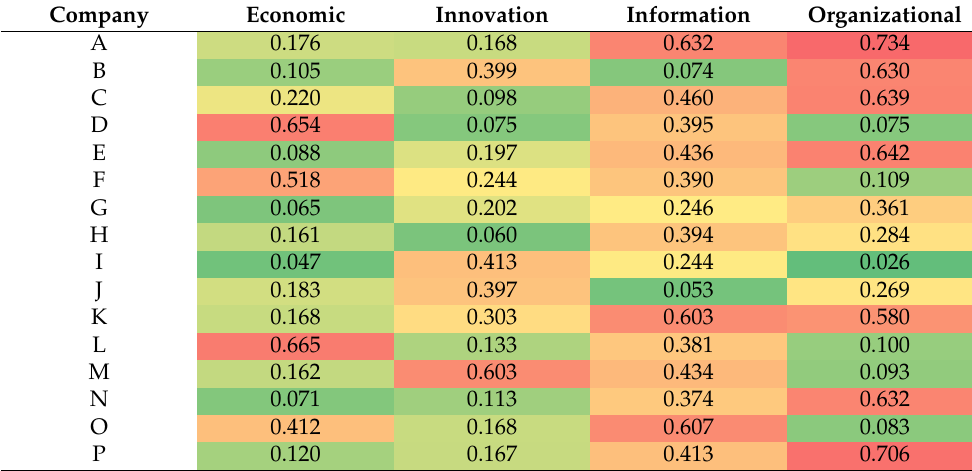
Table 4. Map of the integrated development of the studied enterprises.